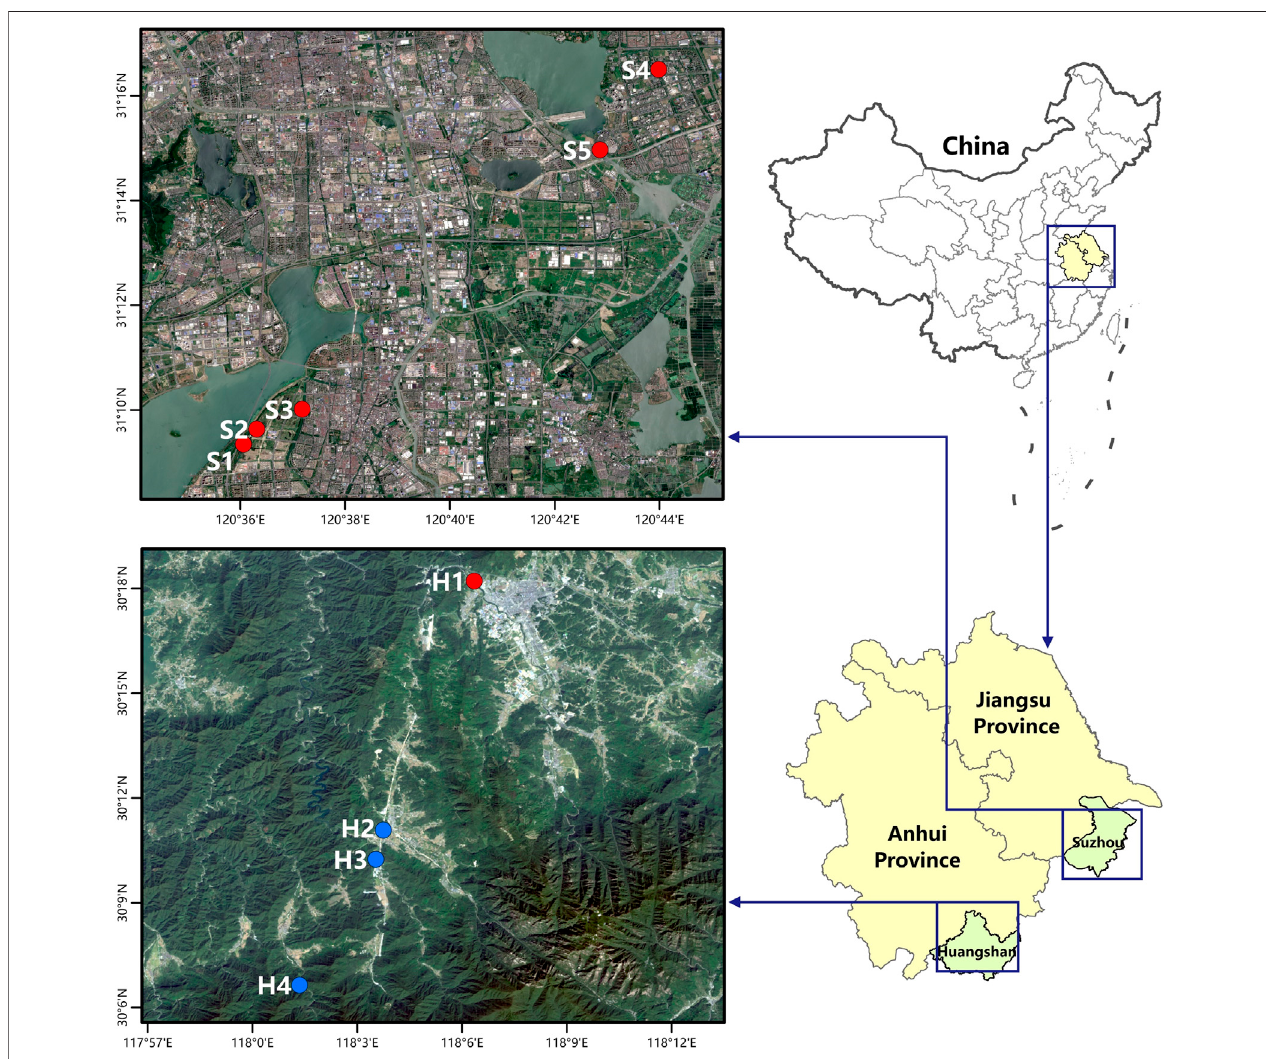
FIGURE1| Locationsofthenine streams inSuzhou(upper left) and Huangshan (lower left).Red and blue circles represent urban and forest streams, respectively.